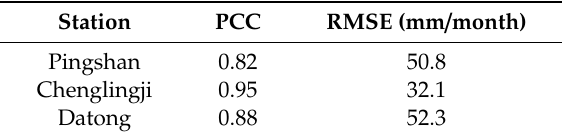
Table 2. Statistical comparison between the remotely sensed precipitation data and the observed precipitation data at the three selected stations, located along the upper, middle, and lower reaches of the Yangtze River